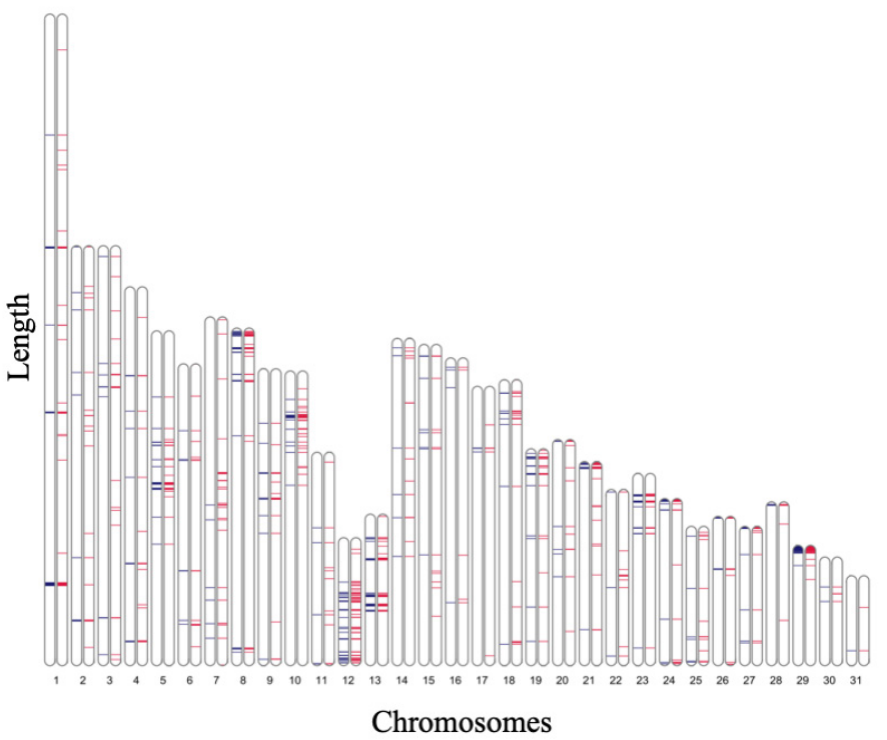
Figure 4. Locations of insertions and deletions (INDELs) and single-nucleotide variants (SNVs) with a MAF of 0.5 and heterozygous genotypes in all horses. Blue: INDELs detected in this study; pink: SNVs detected in our previous study. Many regions are matched between the loci of SNVs and INDELs. The pericentromeric region (position: 1–2,261,991, approximately 2.26 Mb) of ECA29 was densely distributed.